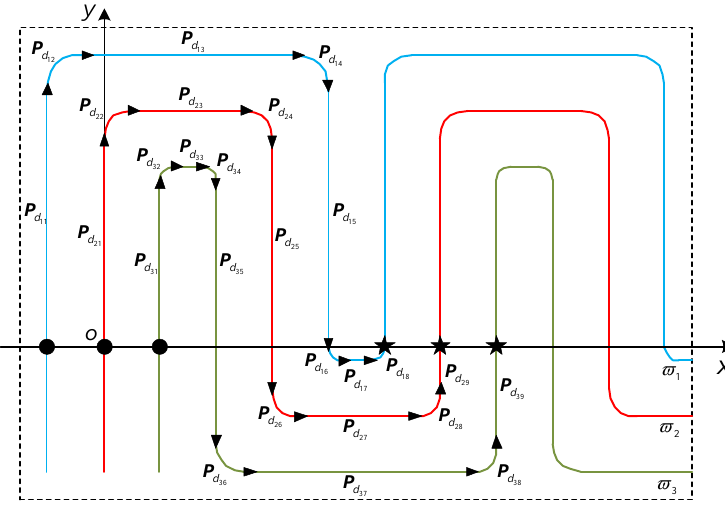
Figure 3. Illustration of the coverage path-planning (CPP) design.